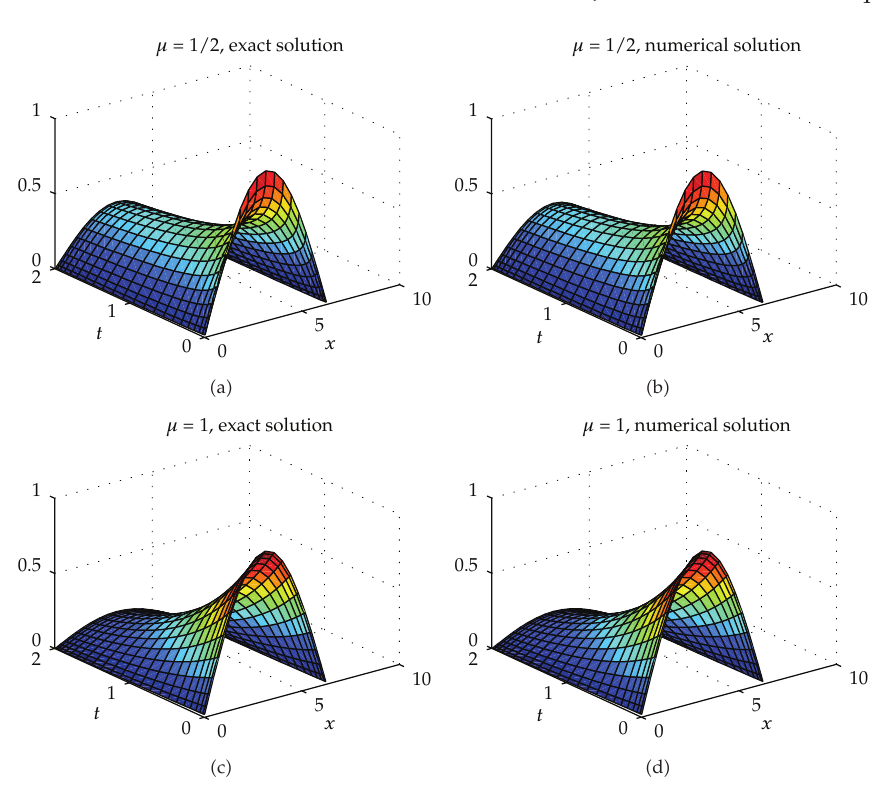
Figure 10: Exact and numerical